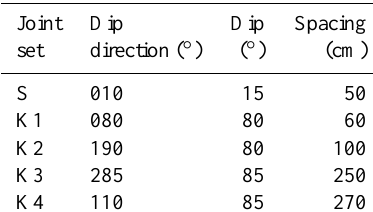
Table 1. Main joint sets affecting the rock mass outcropping on the cliff. S: bedding planes; K1–K4: structural joints.